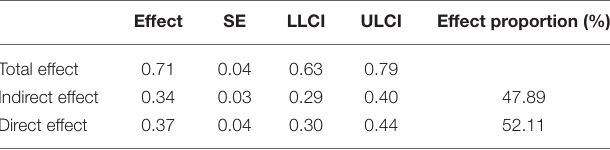
TABLE 3 | Distribution of the total effect, direct effect, and intermediary effect.